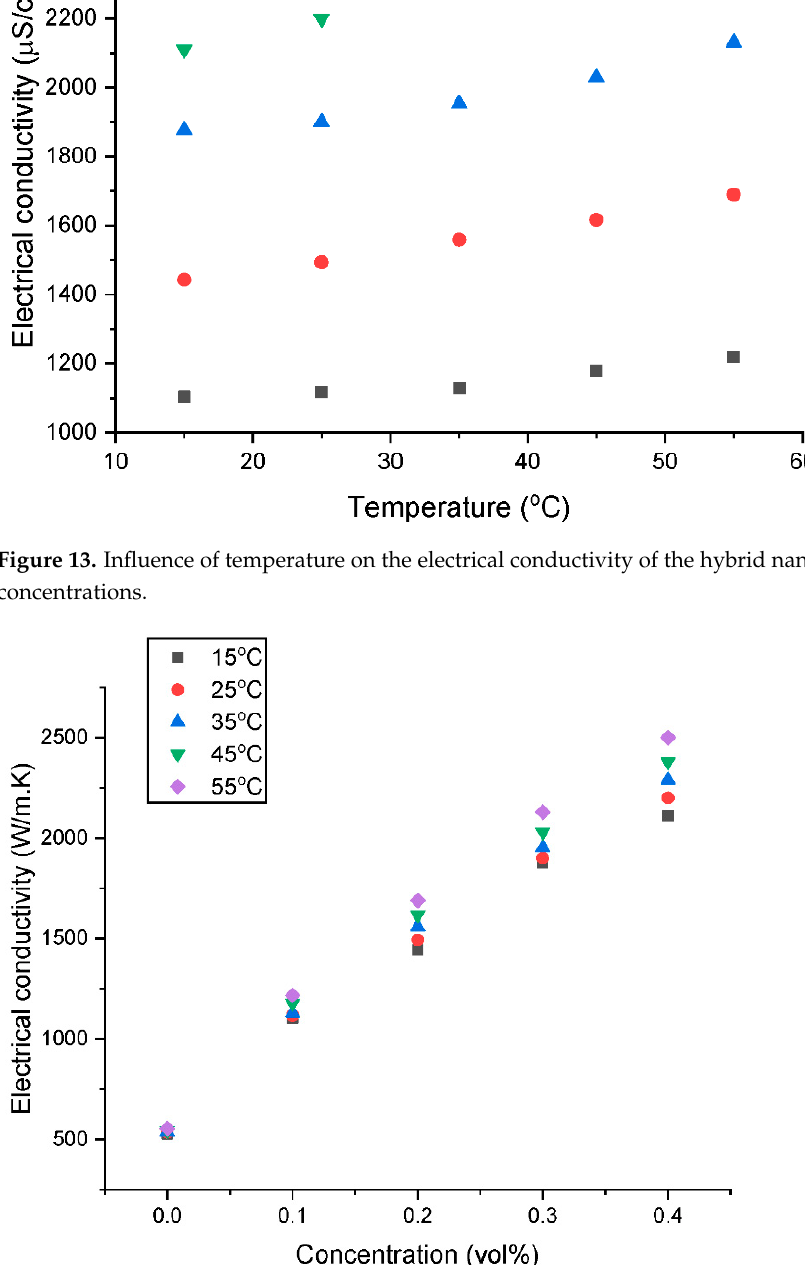
Figure 14. Influence of concentration on the electrical conductivity of the hybrid nanofluids at various temperatures.